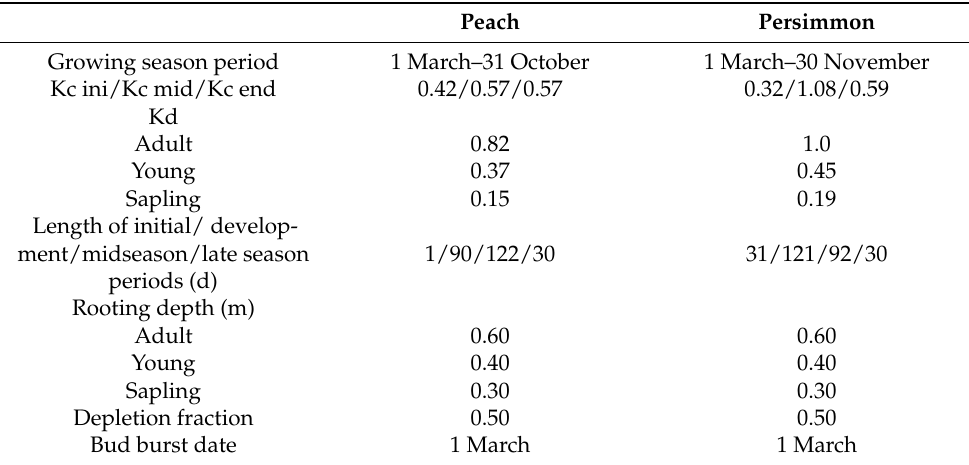
Table 4. Crop data for Cropwat ET c calculations.